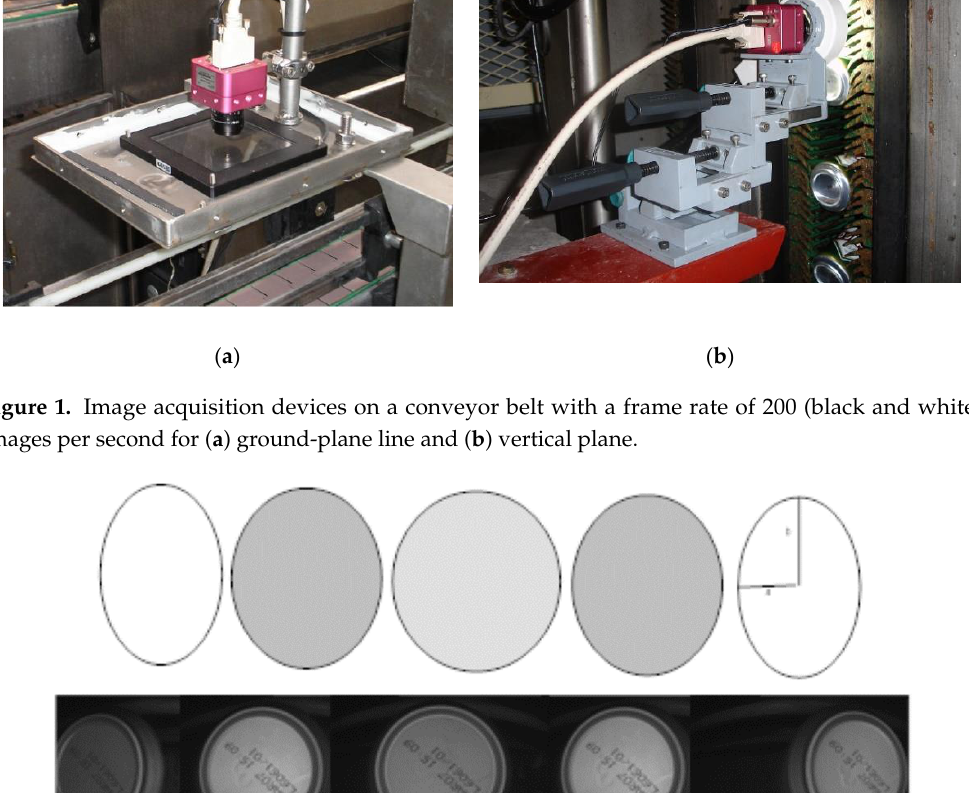
Figure 1. Image acquisition devices on a conveyor belt with a frame rate of 200 (black and white) images per second for ( a ) ground-plane line and ( b ) vertical